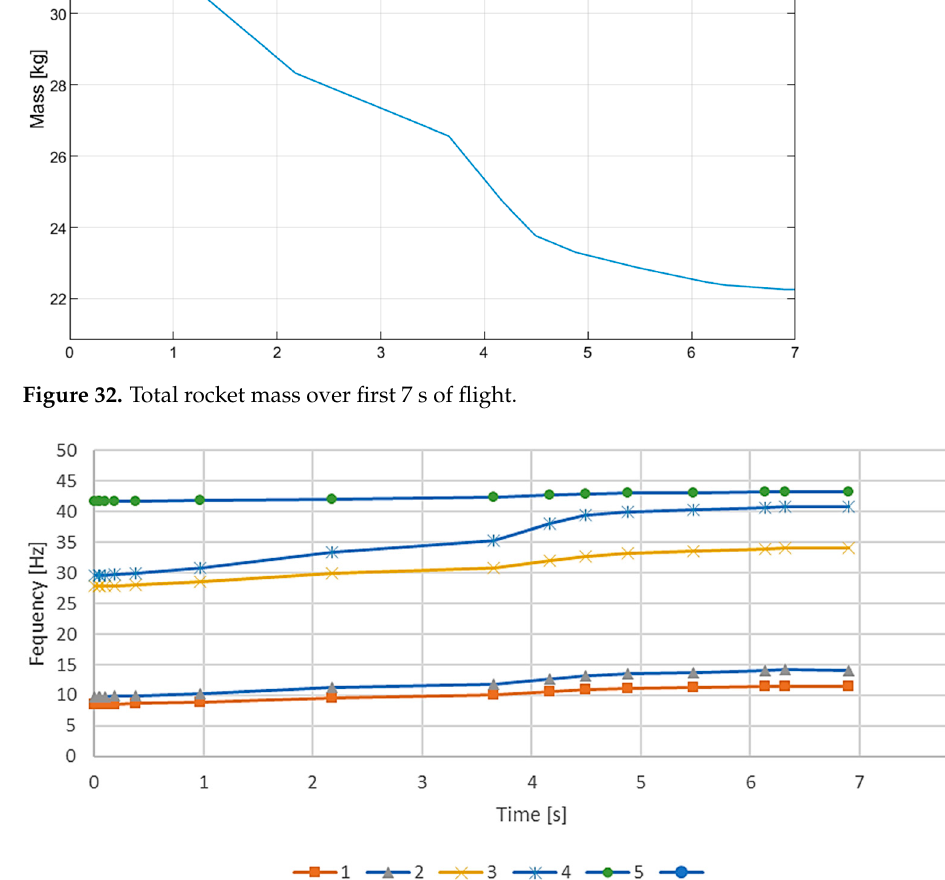
Figure 33. Rocket time-frequency graph with varying mass.